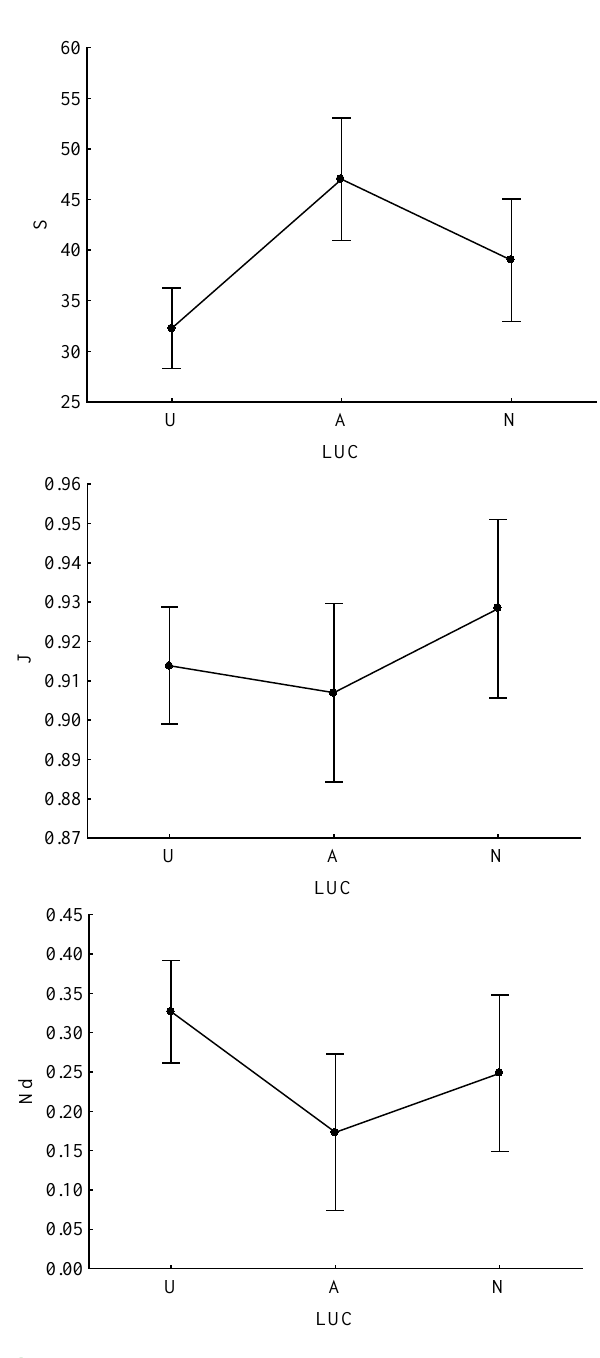
1137 Figure 5. MANOVA plots illustrating average structural parameter values of bird communities for 13 selected land use categories be- longing to urban (U), agricultural (A) and natural (N) habitats. Ver- tical bars denote 0.95 confidence intervals. Community parameter abbreviations: S = species richness; J = Evenness; Nd = dominant species.